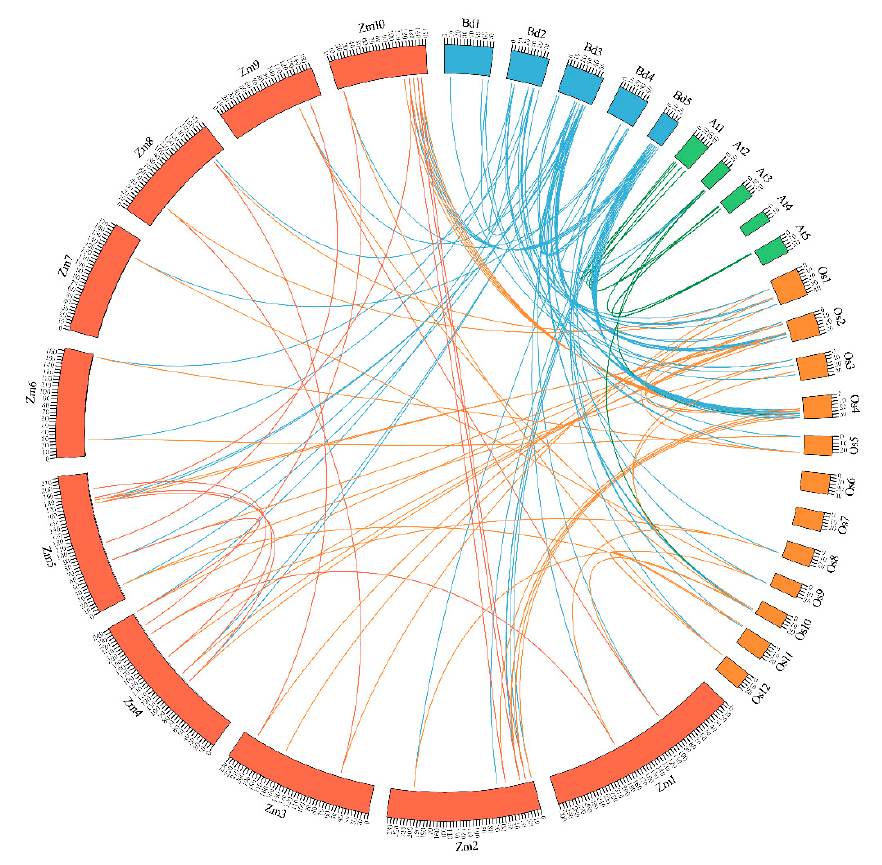
Figure 6. The syntenic analysis of GT genes among Arabidopsis , maize, rice, and B. distachyon . Schematic representation of 135 couples of duplicated genes was displayed on 5 Arabidopsis chromosomes, 10 maize chromosomes, 12 rice chromosomes, and 5 B. distachyon chromosomes by connecting lines using the CIRCOS software. The size of chromosomes was consistent with the actual pseudo-chromosome size. Positions are in Mb.